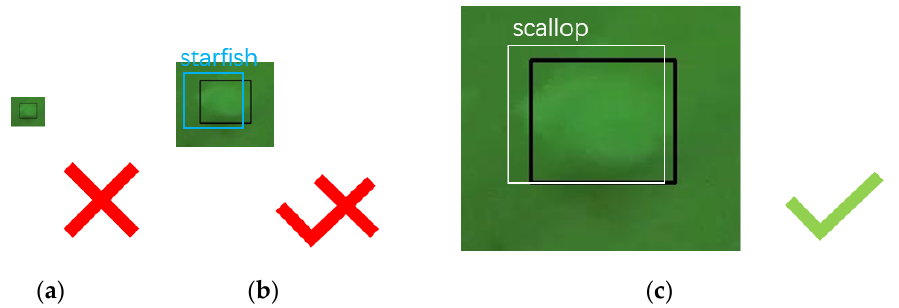
Figure 3. An example of a small target (scallop) being correctly detected after size expansion: ( a ) the target is in small size; ( b ) the small target is slightly enlarged; and ( c ) the target is expanded to be large enough.